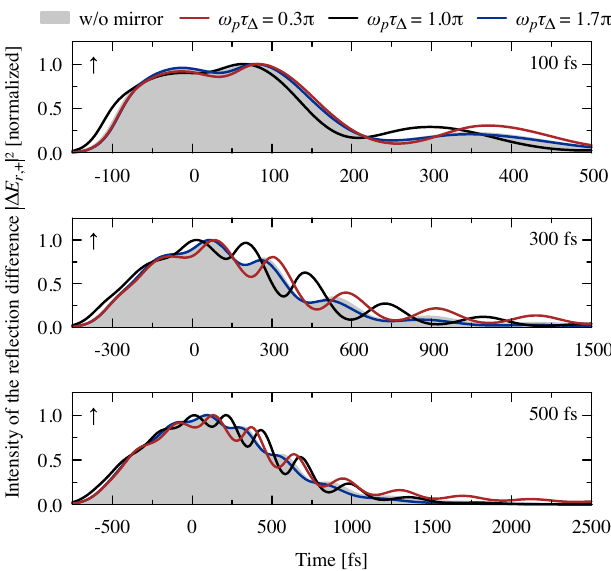
τ 0 . 3 π , 1 . 0 π , Δ ¼ p ϵ is resonant to p ¼ x; (cid:3) at the feedback phase x; (cid:3) Fig. 10. Strikingly, the opposite holds true for the nonlinear coherent oscillations, and the red curves in Fig. 10 show larger oscillation depths compared to the response without feedback shown as gray shaded areas. The enhancement of the nonlinear coherent oscillations originates from a decreased exciton-biexciton energy separation ϵ ϵ < 0 ) leading to increased biexciton oscillator ( δ b r